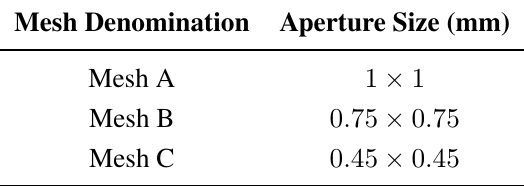
Table 1. Types of metallic meshes